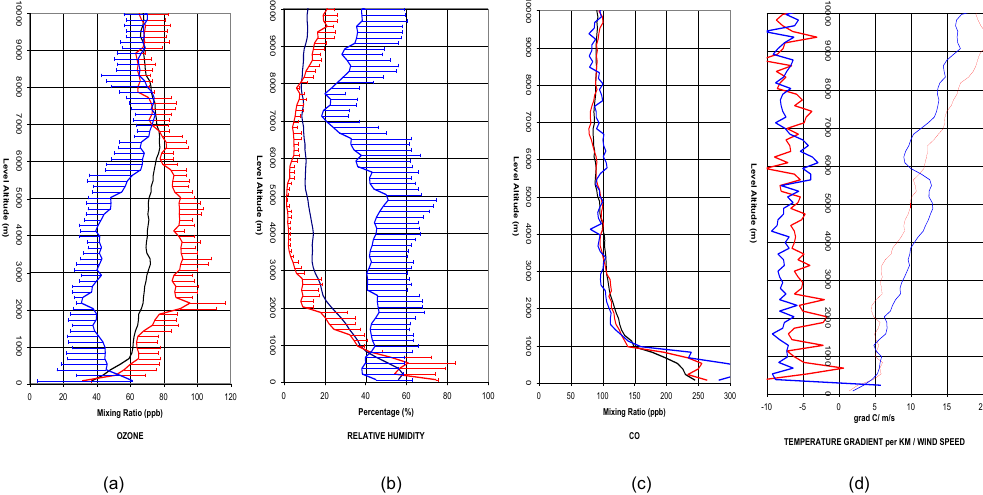
Figure 8. (a).Vertical profiles of summer (JJA) ozone over the Eastern Mediterranean airport of Cairo for the 7% highest (red) and the 7% 3 Fig. 8. (a) Vertical profiles of summer (JJA) ozone over the eastern Mediterranean airport of Cairo for the 7% highest (red) and the 7% lowest (blue) ozone mixing ratios at 1500-5000m., (b). Same as (a) but for relative humidity, (c). Same as (a) but for carbon monoxide (CO), 4 lowest (blue) ozone mixing ratios at 1500–5000m; (b) same as (a) but for relative humidity; (c) same as (a) but for carbon monoxide (CO); (d) (left), same as (a) but for temperature gradient per km; (right), same as (a) but for wind speed. The black line in (a, b, c) , shows the mean (d). (Left), Same as (a) but for temperature gradient per km, (Right), Same as (a) but for wind speed. The black line in (a), (b), (c), shows the 5 profile of the respective parameter. mean profile of the respective parameter. 6